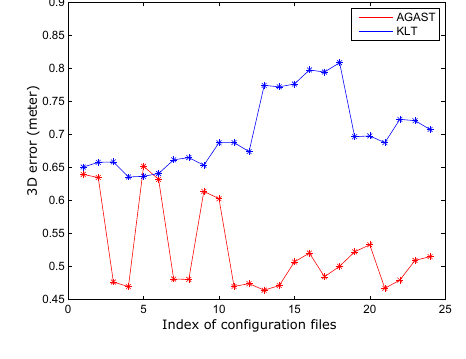
Figure 8: 3D-errors for 24 configuration